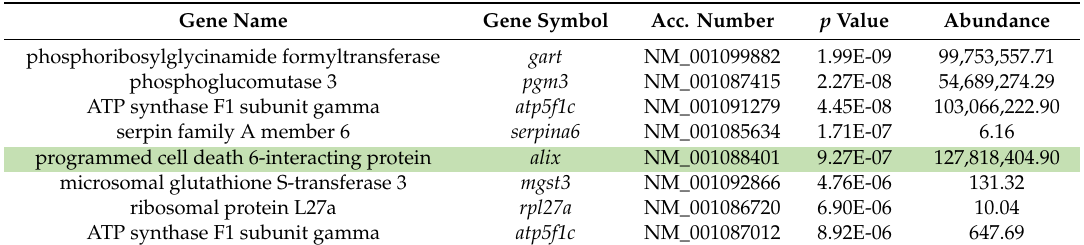
Table 1. Identified Candidates for Trim2-Interacting Proteins by GST Pulldown and High-Throughput LC-MS /